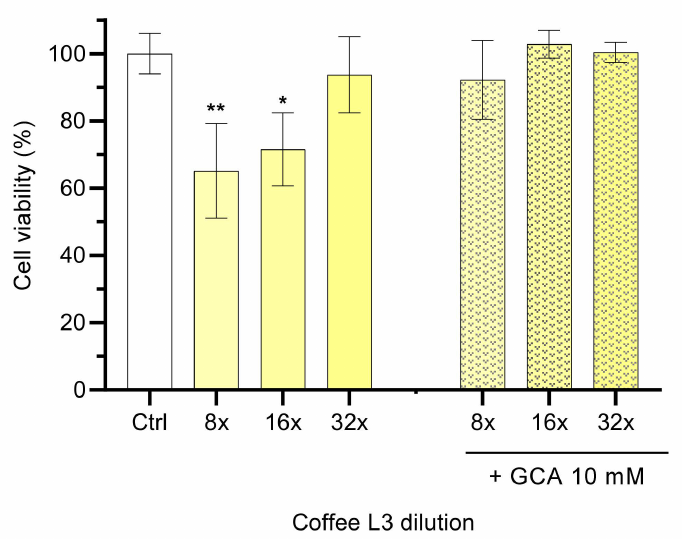
Figure 2. Effect of the light roasting with a coarse level coffee extract (L3) and its mixtures with GCA 10 mM on the viability of Caco-2 cells. The cell viability results are shown for coffee diluted 8- to 32-fold by a factor of four after cell exposure for 6 h. Dilutions were prepared with HBSS or GCA 10 mM in HBSS. Statistically significant differences between the negative control (HBSS) are represented as * p < 0.05 ** p < 0.01, n ≥